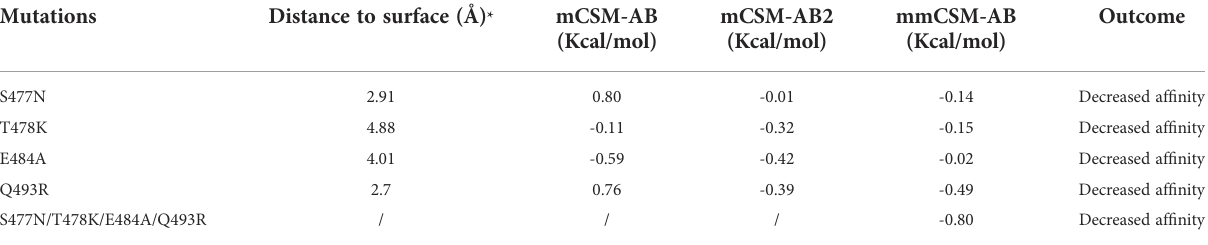
TABLE 5 Mutation effects on the Spike-Ab complex.